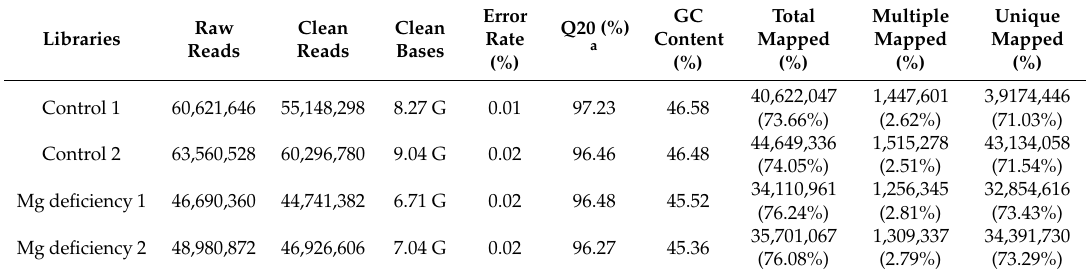
Table 1. Basic information of transcriptomic analysis of C. sinensis leaves under di ff erent Mg